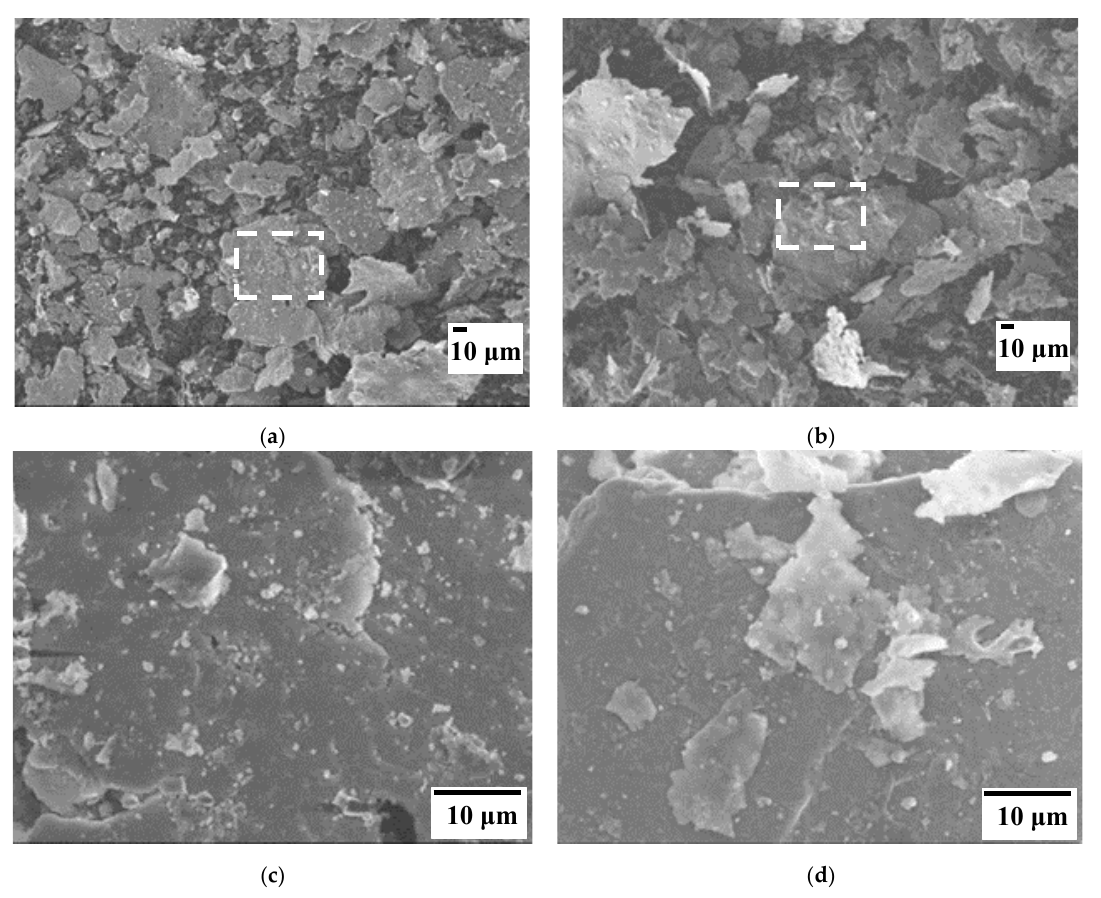
Figure 5. FESEM images of selected starting powders: ( a ) 15G1; ( c ) is a magnification from the boxed area in ( a ); ( c ) 05G2; ( d ) is a magnification from the boxed area in ( b ). All the starting powders have been consolidated by SPS, and the XRD patterns of the starting powder 15G1 and sintered samples 15G1-SPSed and AA7075-SPSed are reported in Figure 6. For the starting powder 15G1, Figure 6a shows intense Al peaks and weak peaks attributed to the various compounds initially present in the G1/EAFD powder (Fig- ure 2a), even for this sample with 15 wt. % G1. The similarity between the XRD patterns of 15G1 starting powders (Figure 6a) and the 15G1-SPSed sample (Figure 6b) suggests that no reaction took place during sintering as no new phase was detected. The XRD patterns of the sintered G2/EAFD — AA7075 composites have similar features (not shown). The XRD pattern of the AA7075-SPSed is shown in Figure 6c.